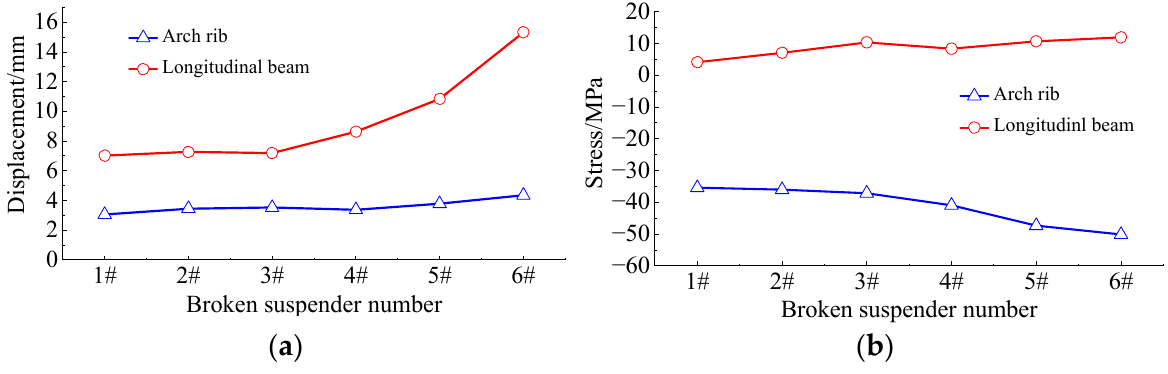
Figure 13. The maximum response due to the breakage of different suspenders: ( a ) displacement; ( b )